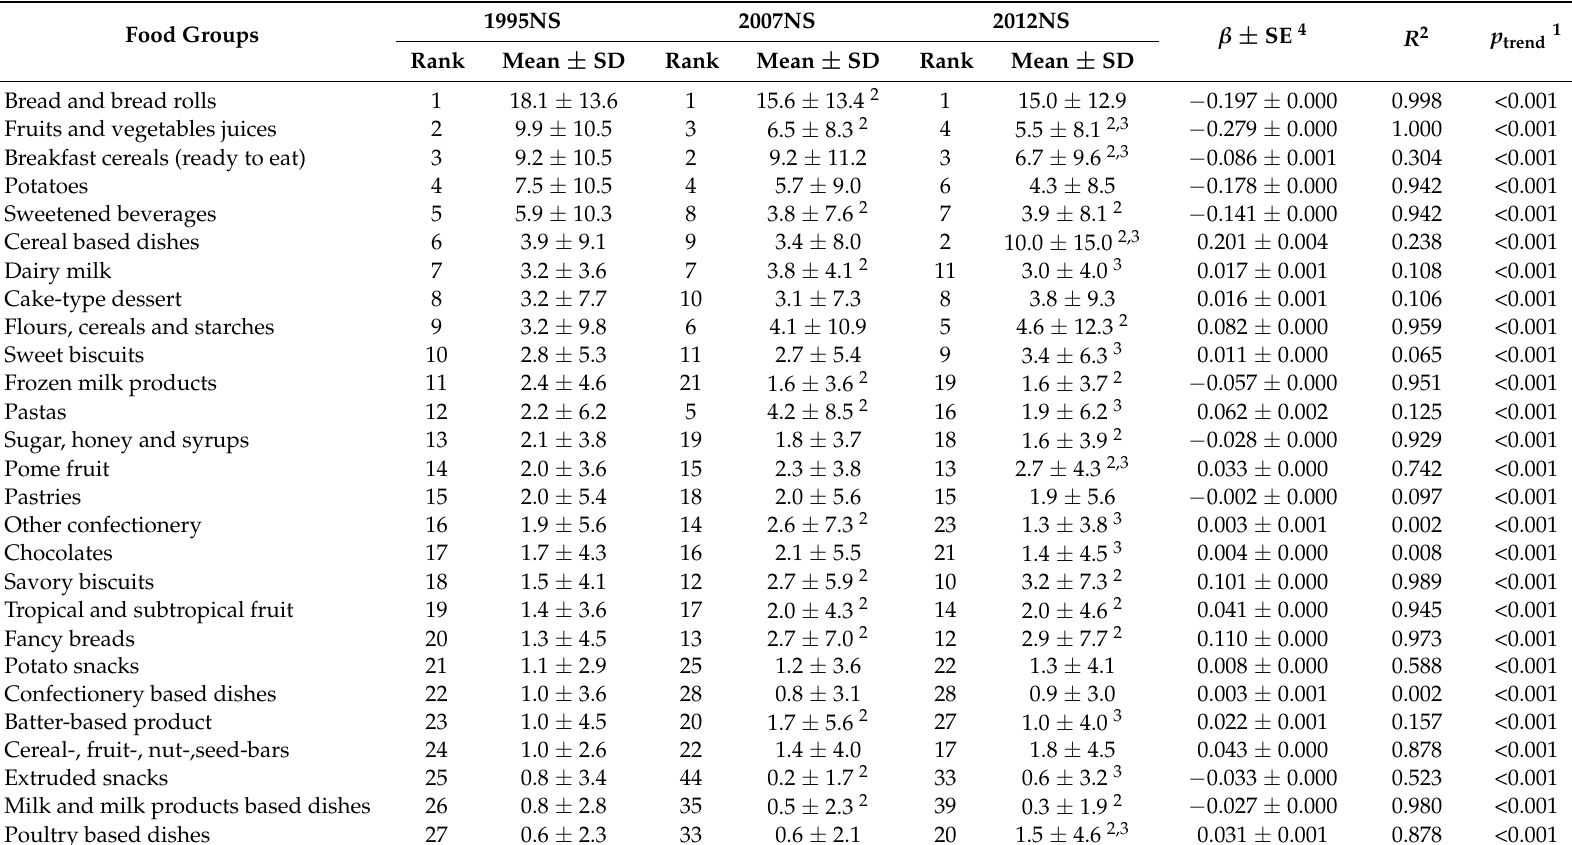
Table 3. Per capita mean ± SD comparison of the highest contributors to glycemic load in the three surveys. Food